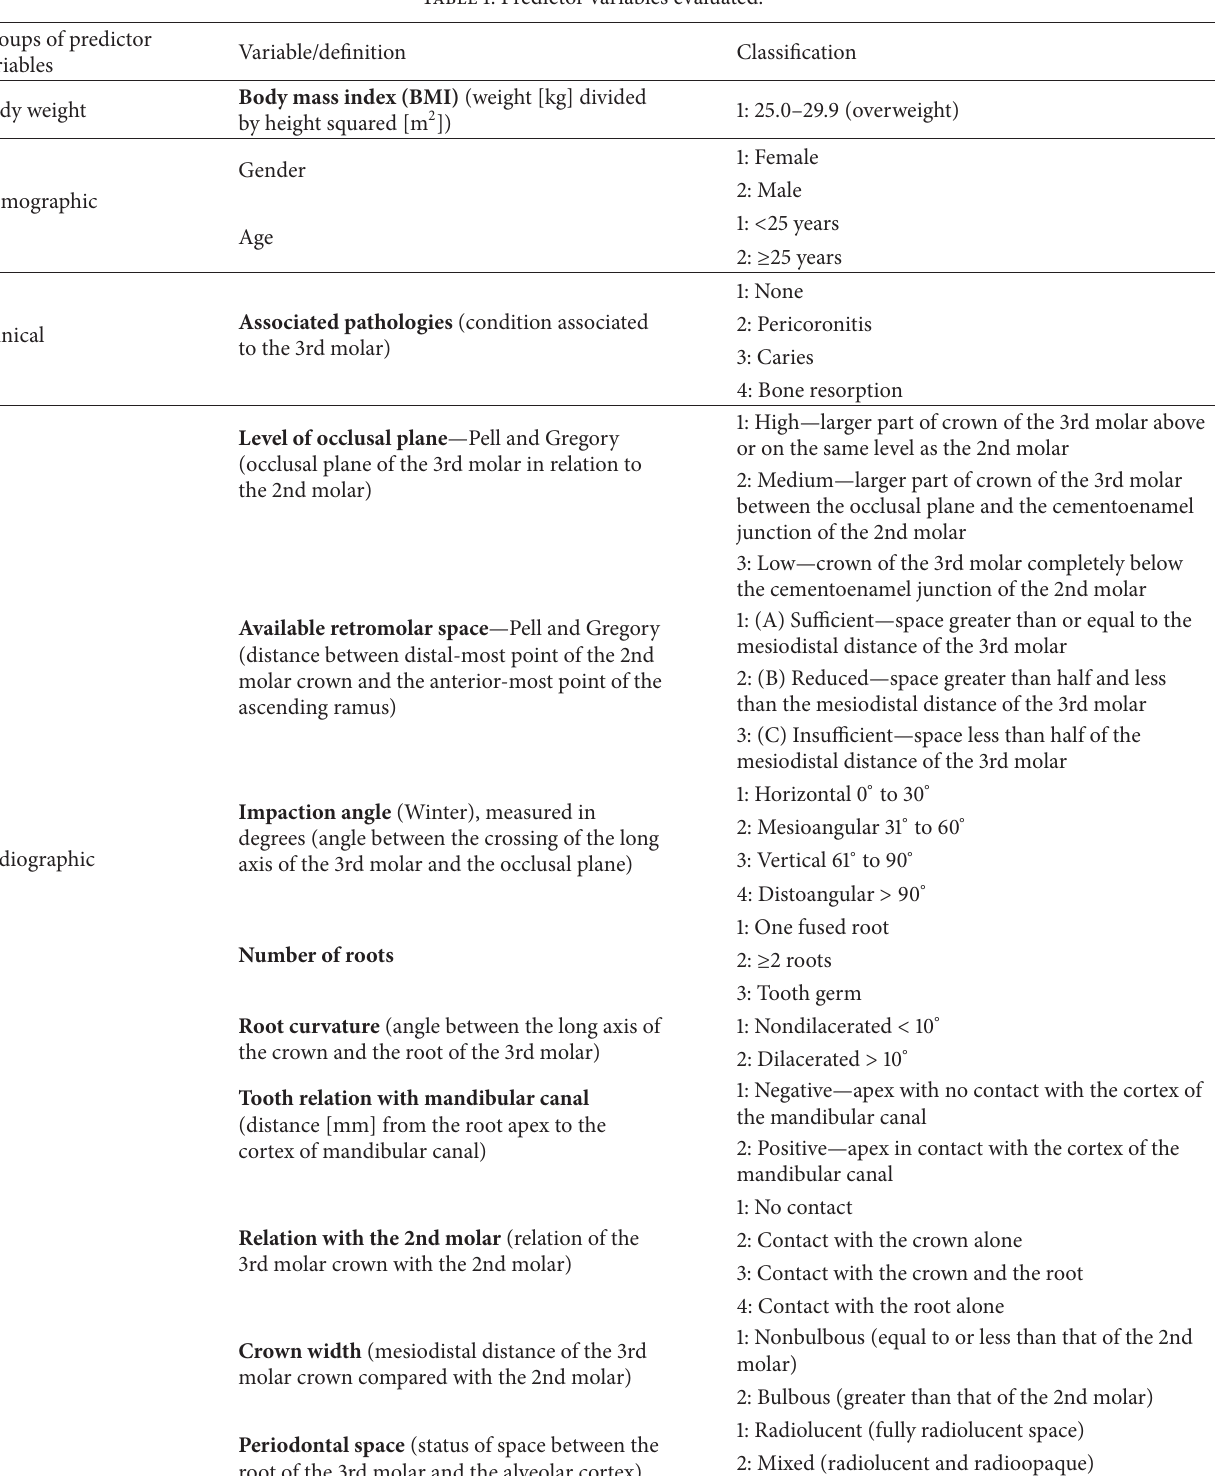
Table 1: Predictor variables